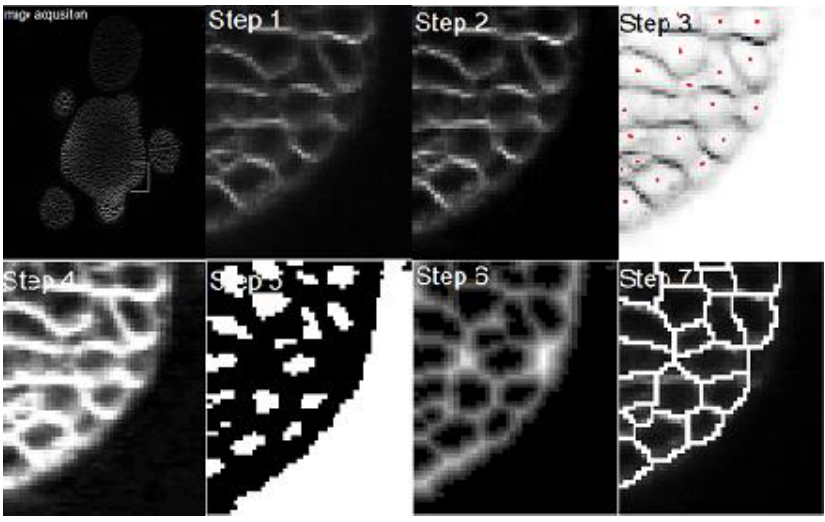
Figure 3. Result images from the steps of the proposed segmentation algorithm.